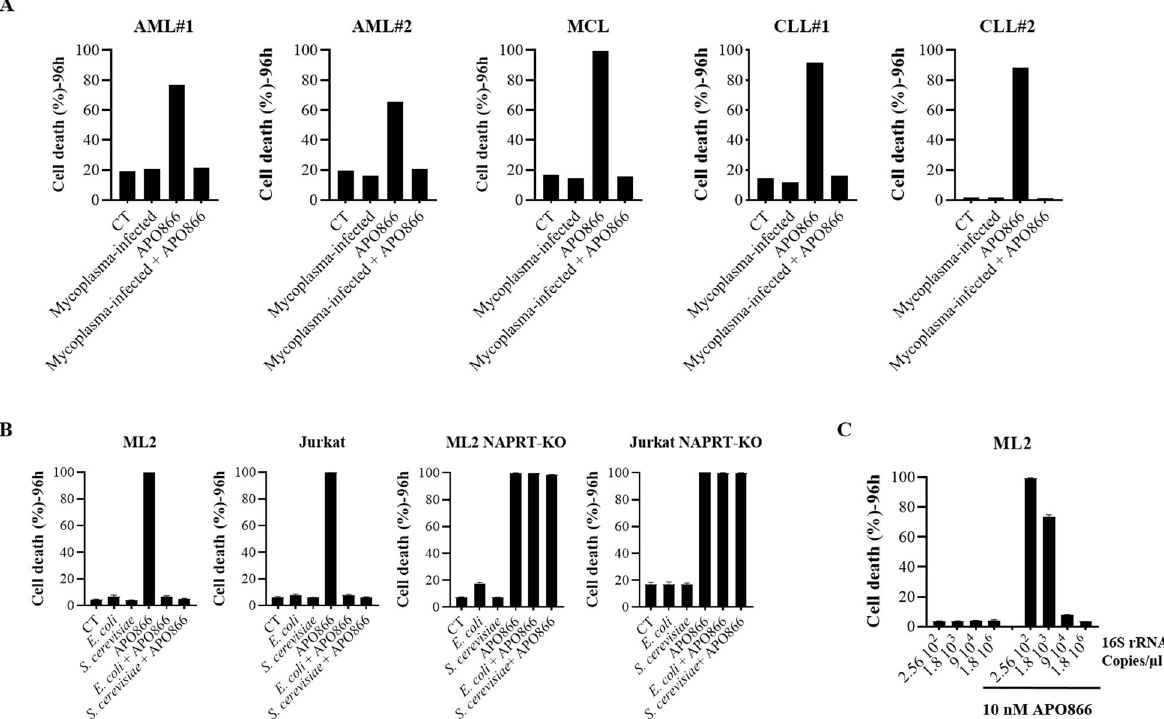
Fig. 2 Bacteria abrogate the anti-leukemic/lymphoma effects of APO866 in primary cells from patients diagnosed with various hematological malignancies and in several leukemia/lymphoma cell lines. Cell death analysis on several uninfected and bacteria-infected primary leukemic cells ( A ) and ML-2 cells infected with different cell number of E. coli exposed to 10 nM APO866 was monitored as mentioned in Fig. 1. APO866 sensitivities of ( B ) ML-2 and Jurkat cells (both either WT or NAPRT-KO) infected with E.coli or S.cerevisiae and of ( C ) ML-2 cells exposed to different E. coli quantities (inocula). Cell death was assessed as described in Fig. 1. Data are mean ± SD, derived from at least three independent